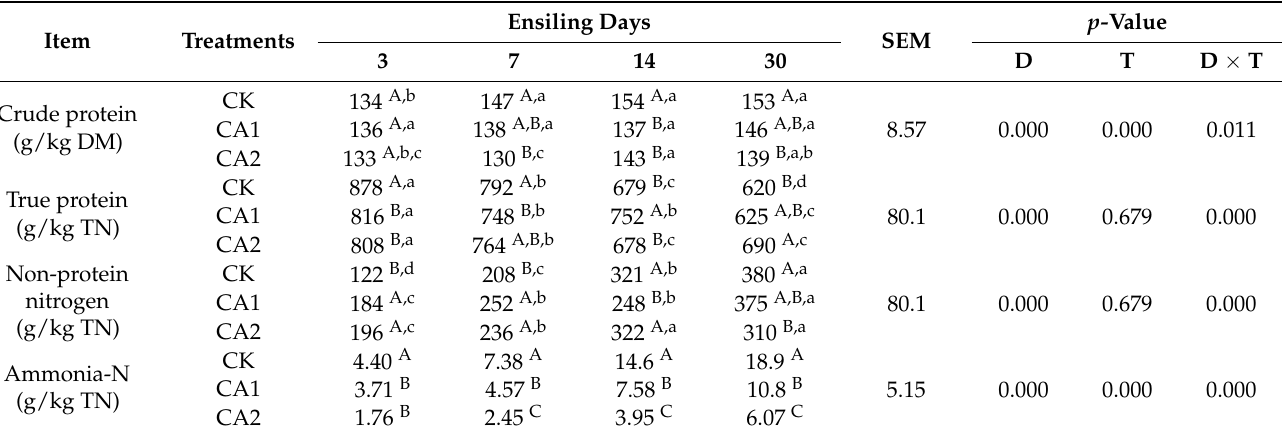
Table 2. The protein fractions of mulberry leaf